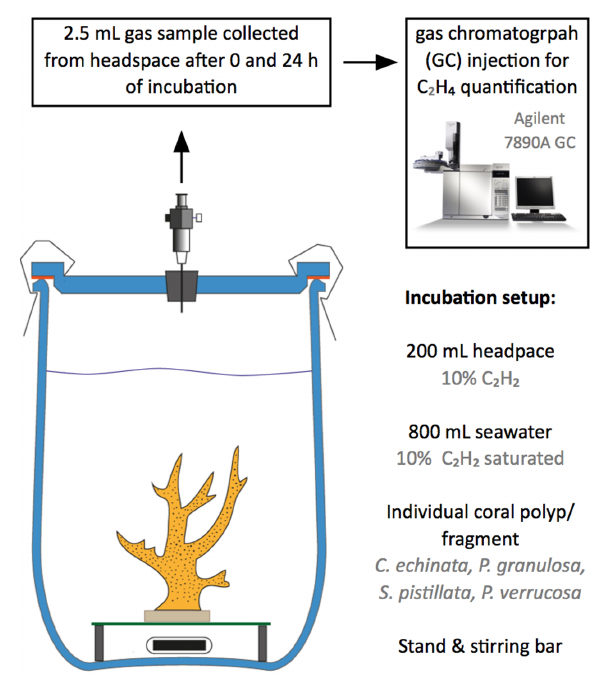
FIGURE 1 | Overview of the incubation setup for the indirect quantification of nitrogen fixation rates of corals using the acetylene (C 2 H 2 ) reduction assay (ARA). Individual coral fragments were incubated in 1 L incubation jars enriched with C 2 H 2 . Gas samples were collected at the start and end of incubation for ethylene (C 2 H 4 ) quantification using gas